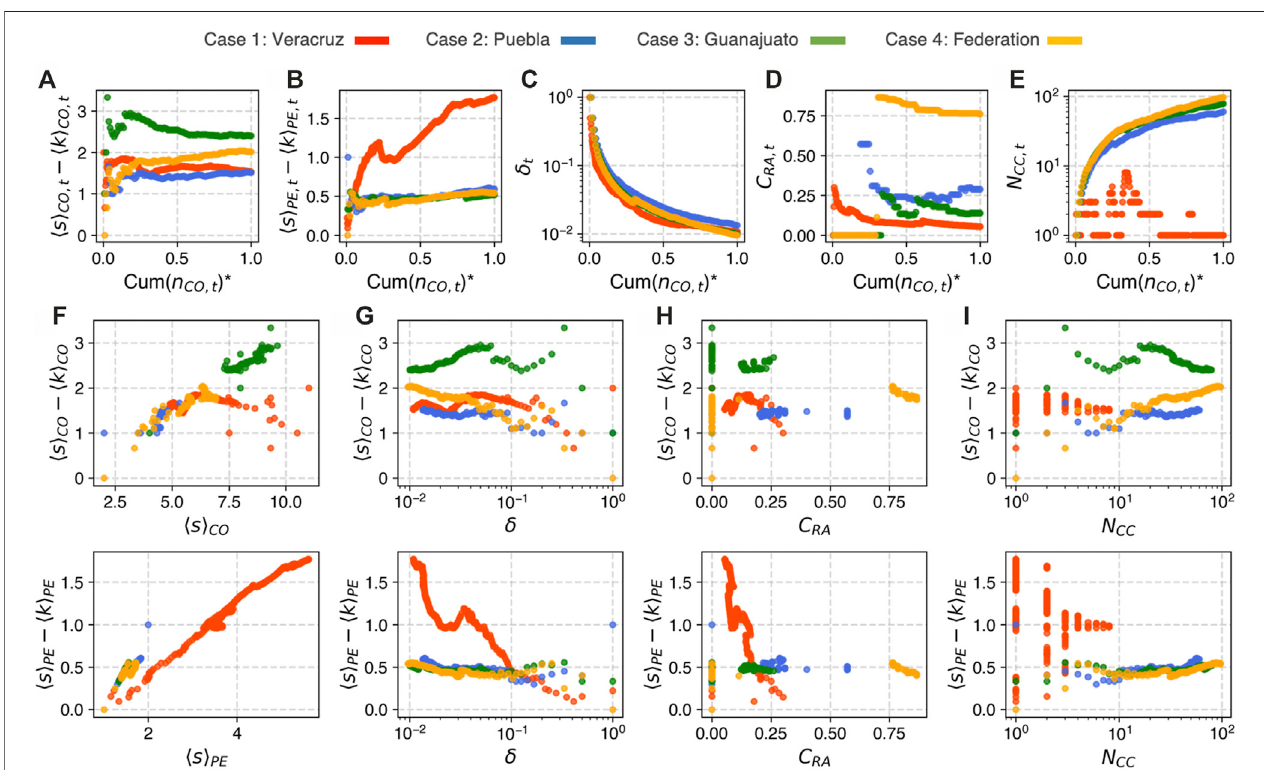
FIGURE 4 | Corporate network dynamics. (A) Mean degree and mean strength difference for company nodes, (B) mean degree and mean strength difference for personnel nodes, (C) density, (D) clustering coef fi cient of Robins – Alexander, and (E) number of connected components. In (A – E) , the temporal variable, Cum ( n CO , t ) * , corresponds to the normalized cumulative number of companies per year. In (F – I) , time is an implicit variable of the data points for the mean degree and mean strength difference for company nodes (top), and the mean degree and mean strength difference for personnel (bottom), as a function of (F) companies mean strength, (G) density, (H) clustering coef fi cient, and (I) number of connected